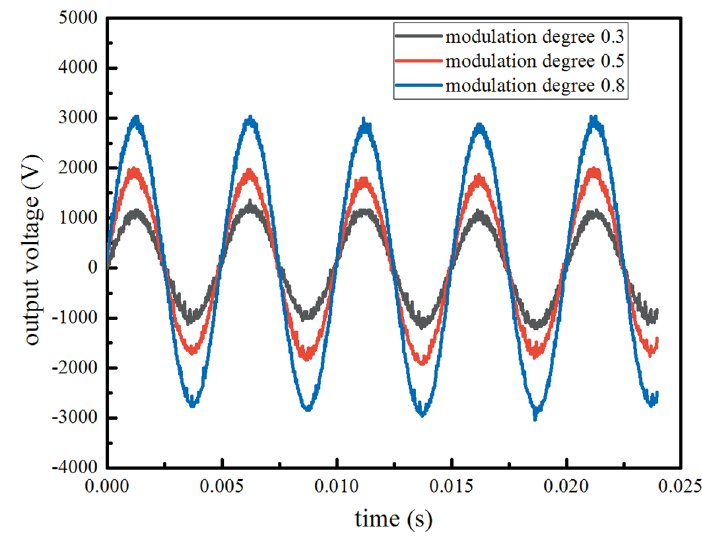
Figure 5. Sinusoidal output voltage waveforms at di ff erent modulation degrees.